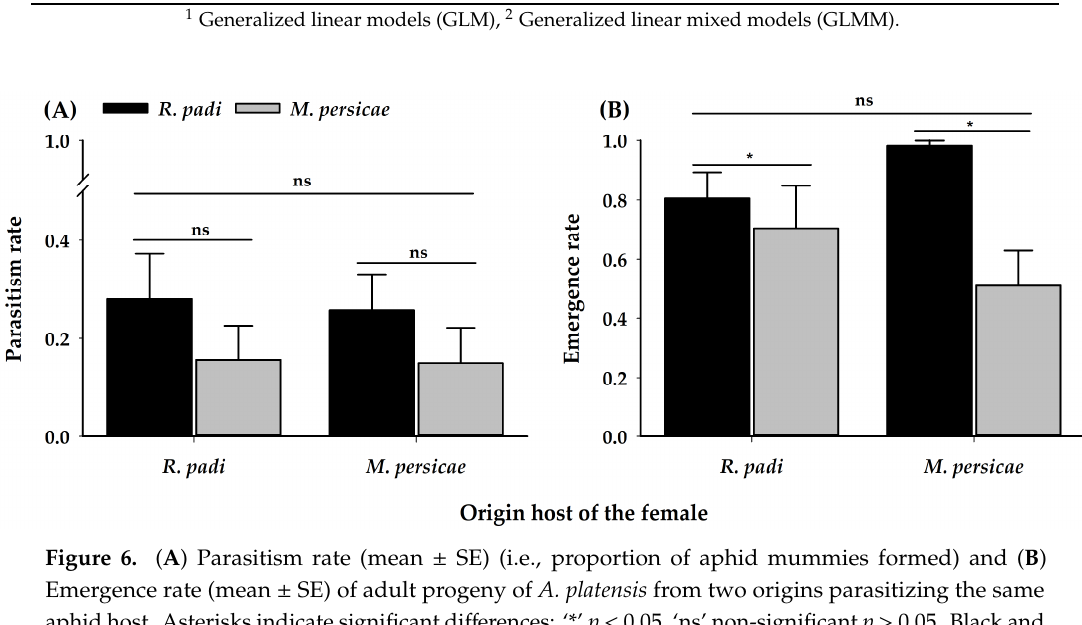
Figure 7. Total developmental time (mean ± SE) of A. platensis emerged from R. padi and M. persicae and coming from two origins ( R. padi and M. persicae ). Asterisks indicate significant differences: ‘***’ p < 0.001, ‘**’ p < 0.01 ‘*’ p < 0.05, ‘ns’ non-significant p > 0.05. Black and grey bars show the chosen/tested host. Additionally, fitness traits were evaluated on the emerging progeny in all treatments. There was no difference in the tibia length of the progeny (Table 2) (Figure 8A), irrespective of the origin host of the mother. However, regardless of the origin of the female, the progeny developing on R. padi was heavier than those developing on M. persicae . (Table 2) (Figure 8B).